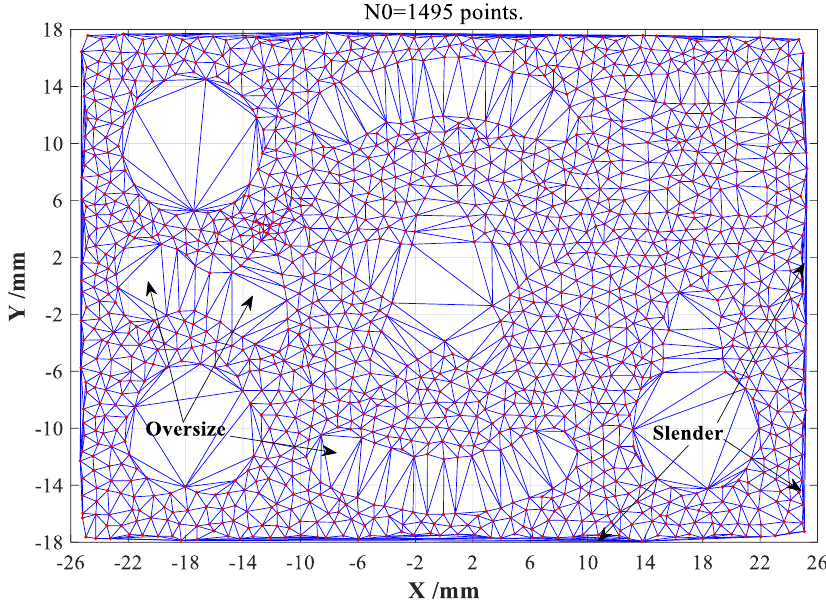
Figure 1. The traditional Delaunay triangular meshes (DTMs) for a complex-shaped